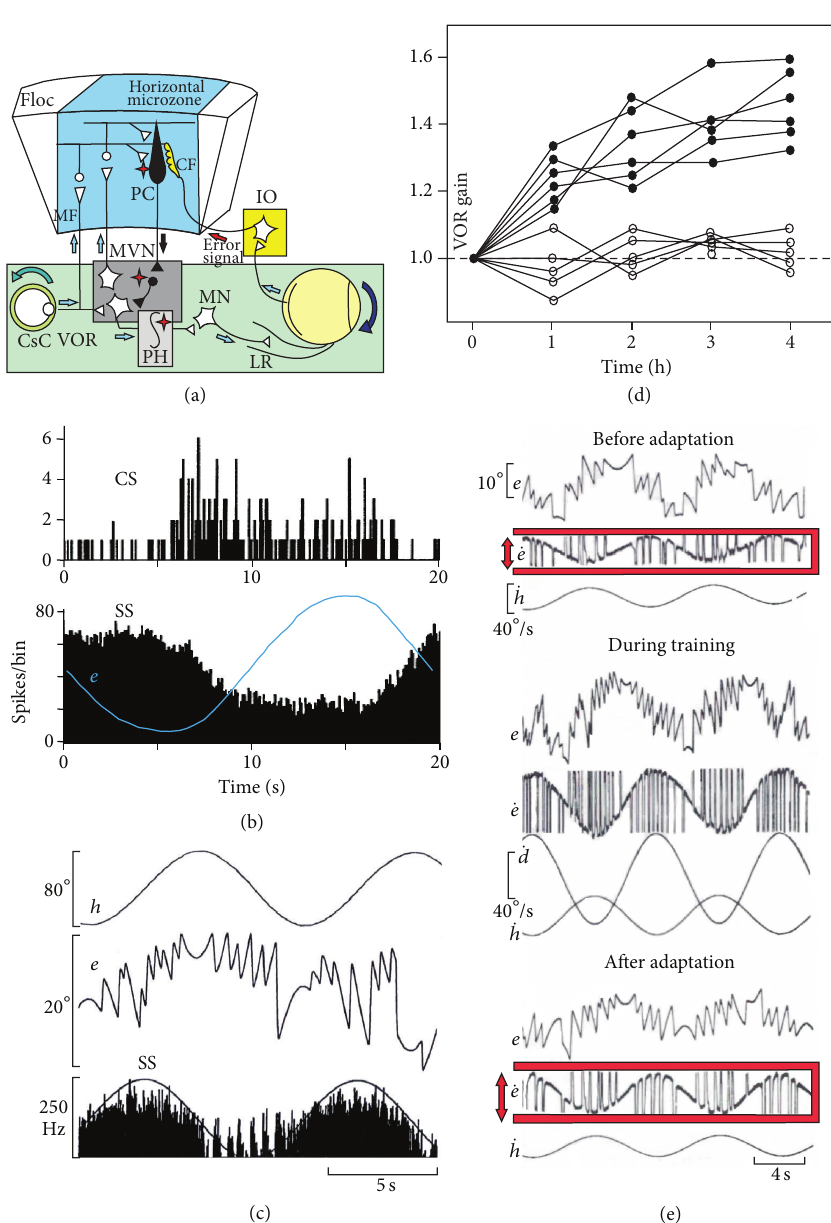
Figure 2: VOR adaptation and Purkinje cell behavior. (a) Schematic diagram of the circuits connecting the VOR pathway including the medial vestibular nucleus (MVN) and the neural integrator located in the prepositus hypoglossa nucleus (PH) and the horizontal microzone of the flocculus (Floc). The error signal initiated by the retinal slip is conveyed via the inferior olive (IO) by the climbing fiber (CF). The asterisk points to possible sites of VOR plasticity (see text for details). (b) Peristimulus time histograms of the complex spike (CS) and the simple spike (SS) responses of a representative Purkinje cell in the horizontal zone of the rabbit flocculus to sinusoidal rotation at 0.05Hz in the light. Note the reciprocity of the CS and SS firing ( adapted from Figure 2 of [80] with permission ). (c) Behavior of head velocity plus eye position sensitivity (HVplusP-P cell) recorded in the horizontal zone of the cat ( adapted from Figure 3 of [24] with permission ). (d) Time course of VOR adaptation corresponding to an out-of-phase VOR-OKN stimulation in 5 cats before (closed circles) and after (open circles) brainstem commissural incision. (e) Example of the VOR adaptation procedure used for increasing the VOR gain. Before the adaptation, the VOR is measured in the dark during table rotation (ℎ) of 40 ∘ peak-to-peak at 0.10Hz; the position of the eye (𝑒) is recorded by means of the search coil technique. The VOR gain is the ratio between the peak-to-peak of the slow phase of the eye velocity and the peak-to-peak of the head velocity. During the training a random pattern of light circles was projected on the drum (d) surrounding the cat and oscillated out of phase of the head rotation, inducing an increase in the amplitude of the eye movements. After 4 hours of such training, the VOR was recorded in the dark and the VOR normalized gain increased by a mean gain of 1.41 ± 0.08 ( adapted from Figures 1 and 2 of [77] with permission ). Abbreviations: CsC, caudal semicircular canal; Floc, flocculus; Mn, motoneuron; OKN, optokinetic; LR, lateral rectus; VOR, vestibuloocular